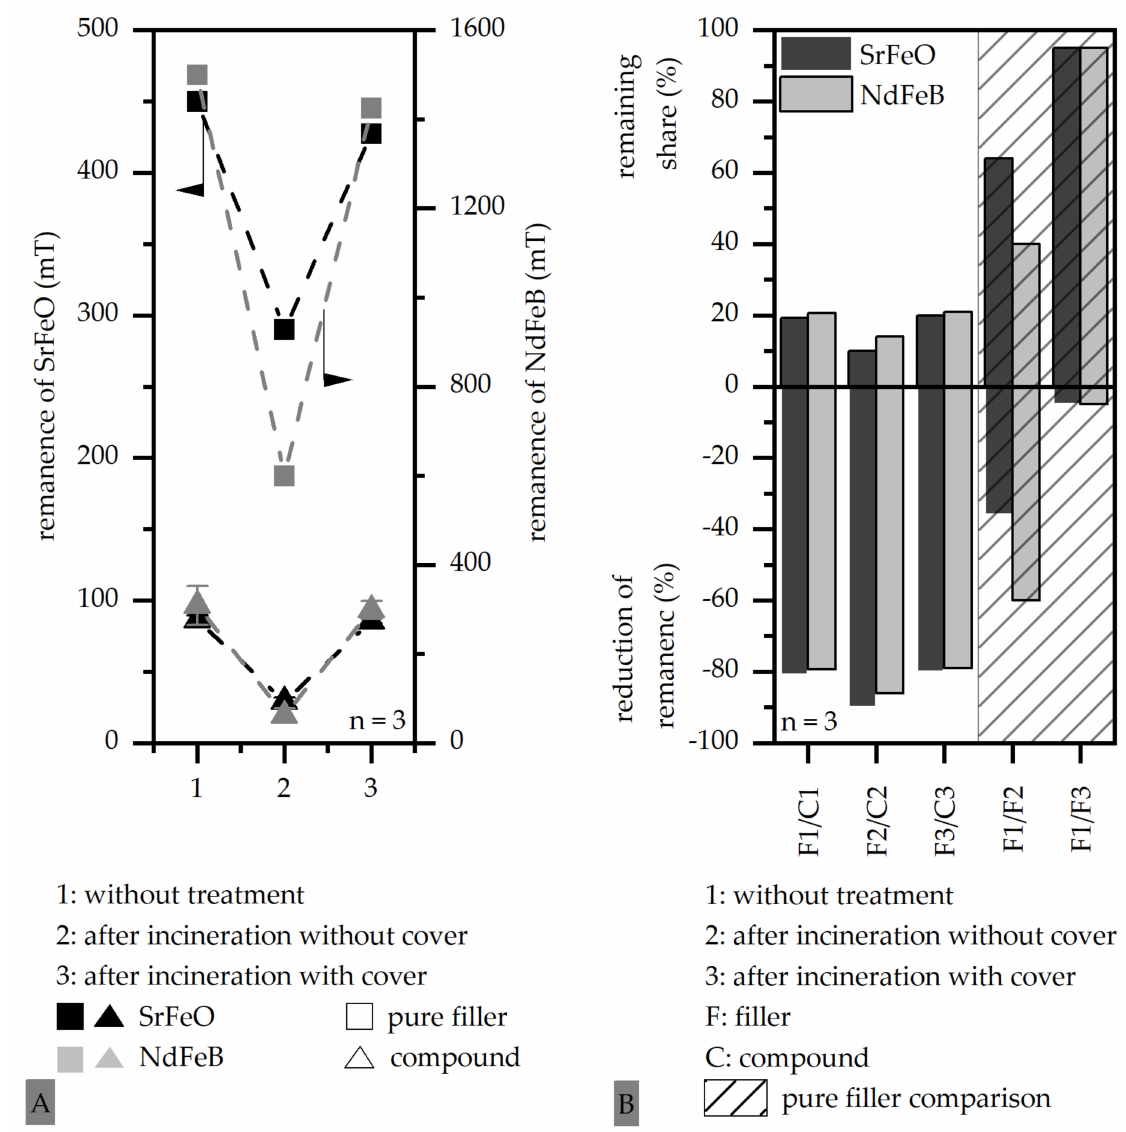
Figure 8. Magnetic properties of the pure filler and the compound ( A ) and comparison of magnetic properties between filler and compound as well as pure filler ( B ) in terms of the